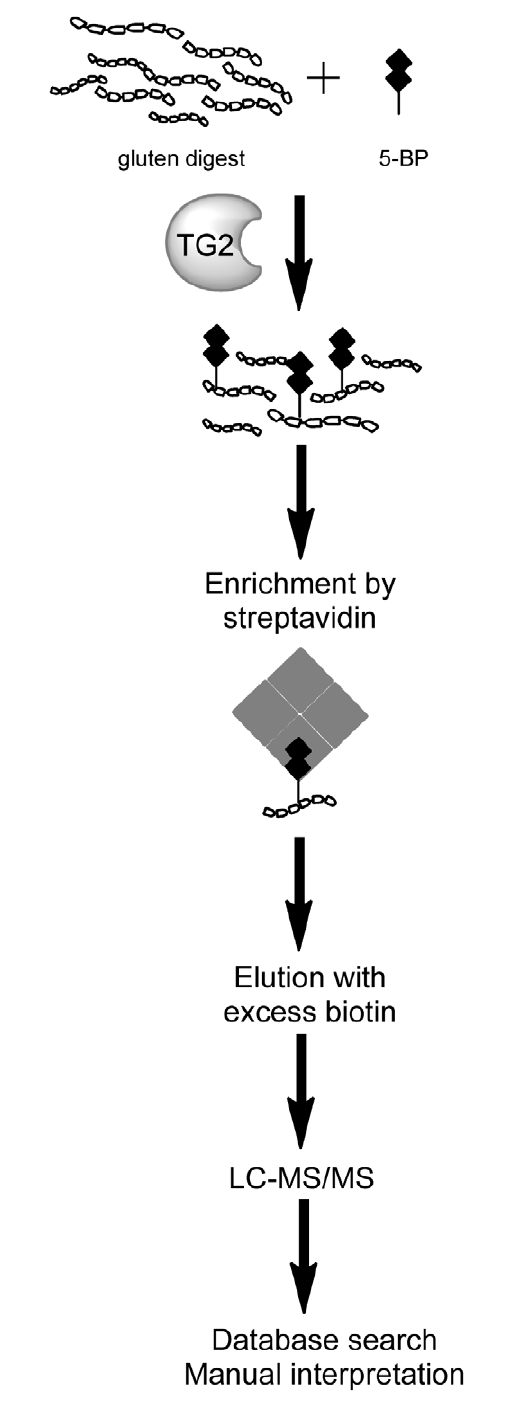
Figure 1. Schematic view of the established method to enrich and analyze TG2 peptide substrates. A PTCEC digest of wheat gluten was mixed with a small amount of 5-BP which served as a substrate for TG2 in a transamidation reaction. The transamidated, biotinylated peptides were enriched from the digest using magnetic streptavidin beads, eluted with an excess of biotin and analyzed by LC- MS/MS. Database searching was performed using a database made up of all entries of Triticum aestivum present in the Uniprot database. In addition, MS/MS spectra were manually inspected.